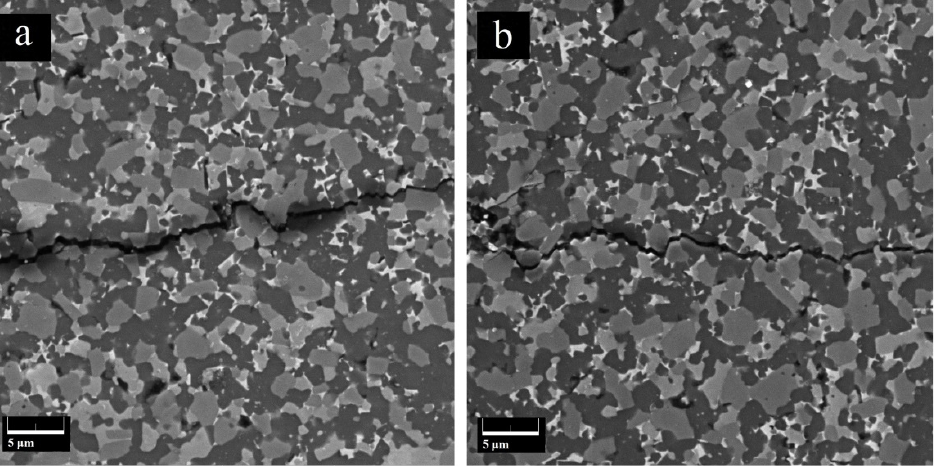
Figure 10. Toughening mechanisms on the crack path in sample 60SiC: ( a ) crack deflection + interface debonding; ( b ) crack deflection + crack branching.